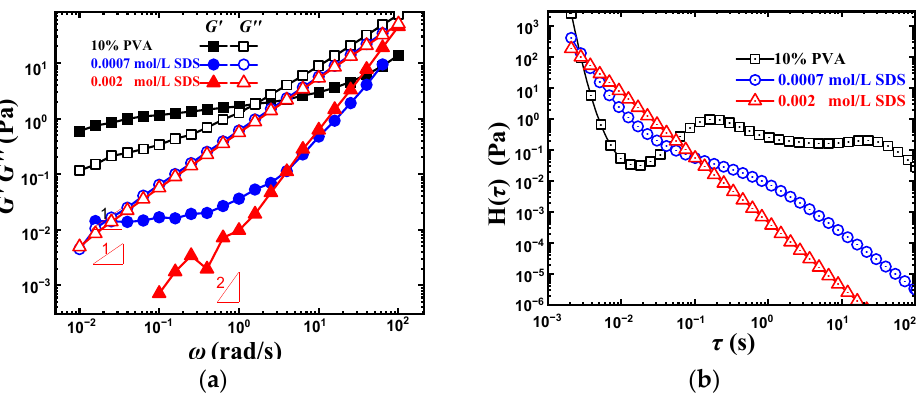
Figure 8. Dynamic rheological behavior and the corresponding relaxation spectrum of 10 wt% PVA with different SDS concentration. ( a ) Dynamic rheological behavior. ( b ) Relaxation spectrum.